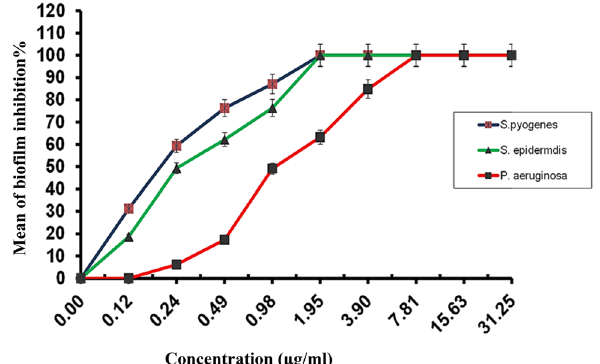
Figure 5. Mean of biofilm inhibitory percentages of RcNps against Staphylococcus epidermidis , Streptococcus pyogenes , and Pseudomonas aeruginosa